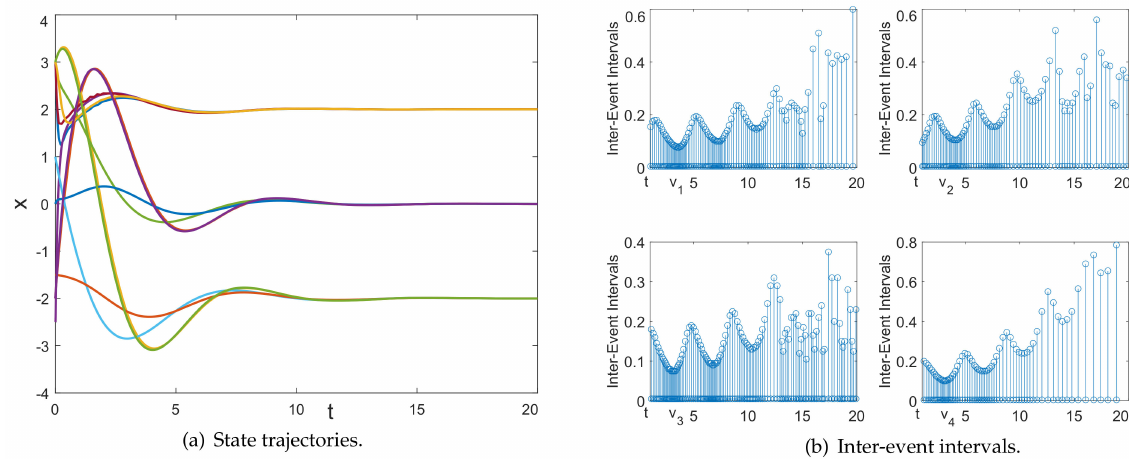
Figure 2. Nonintegral–type edge-event-triggered policy in (29).